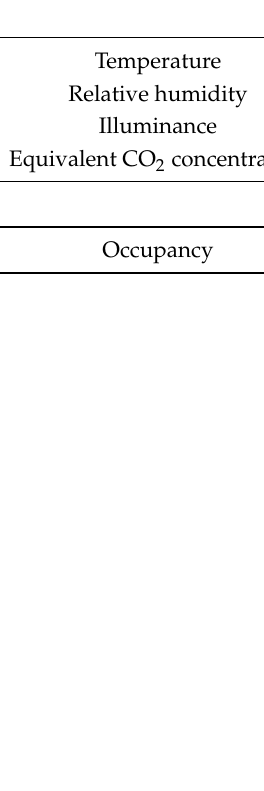
Table 8. Detailed list of inputs and outputs for unsupervised Occupancy Forecasting application.